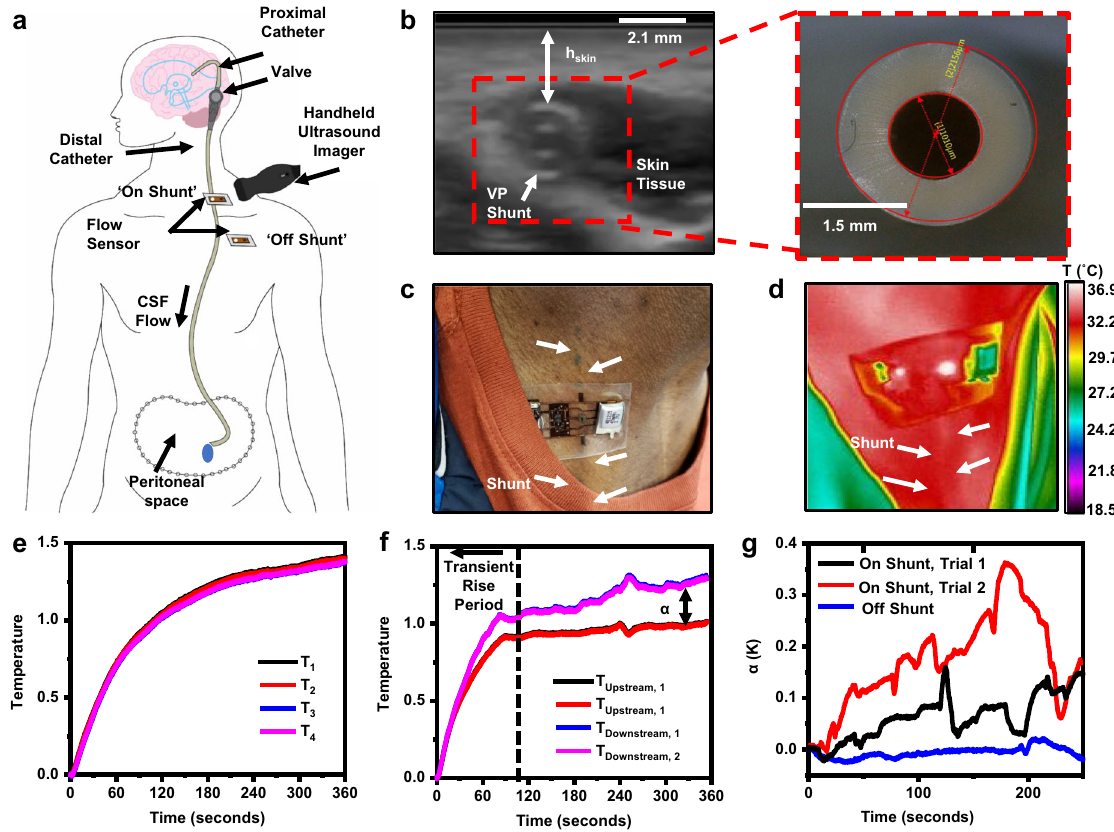
Fig. 3 On-body ultrasound, IR and device measurements on a healthy outpatient (M, 21) with a VP shunt. a Schematic illustration highlighting on-shunt, off-shunt and ultrasound measurement locations. b Ultrasound image of VP shunt at location 2 cm distal to clavicle (left), with optical micrograph of unimplanted shunt (Medtronic, Bactiseal) for scale (right). c Optical image of device mounted on skin over shunt. d IR thermograph of operational device, illustrating a maximum local temperature rise at the thermal actuator of 4.7 °C, with outline of shunt visible downstream of actuator. e Raw temperature recorded from temperature sensors at off-shunt measurement at base of pectoral muscle distal to clavicle. f Raw temperature measurement from four temperature sensors at on-shunt measurement site, showing difference between downstream and upstream temperature signals, α . g α computed for two separate trials on the same patient over the shunt and one trial at off-shunt location. Participants provided written informed consent to have their photos/images included as a part of this publication.